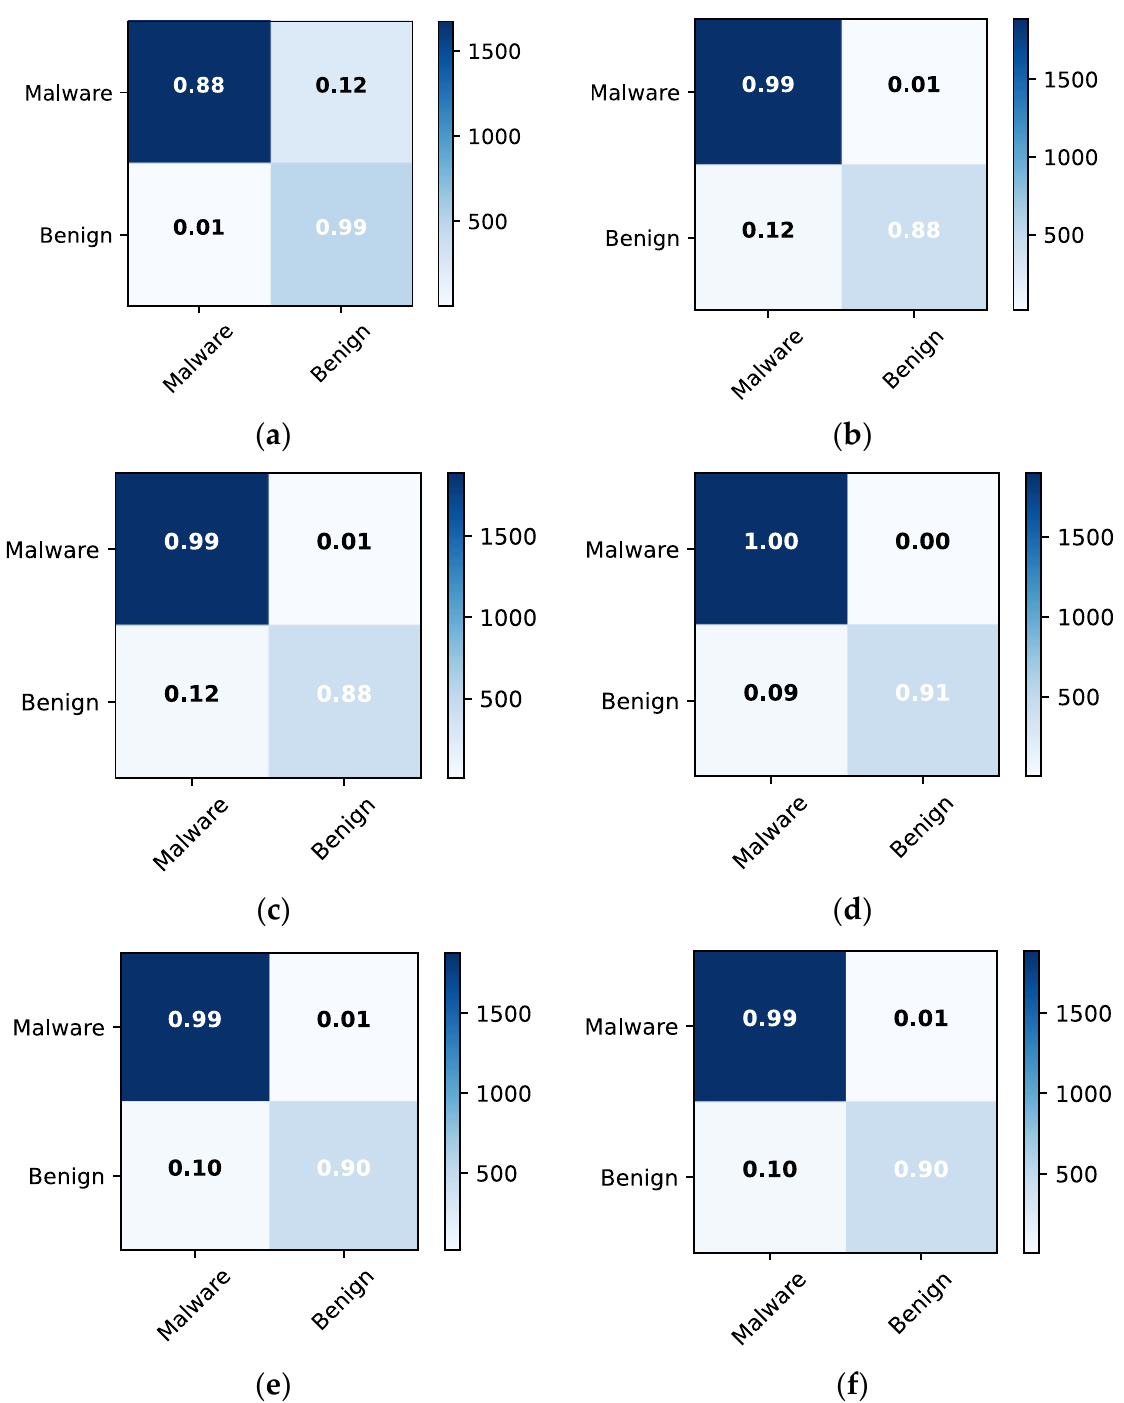
Figure 7. Confusion matrices for malware detection using dataset 2 with 256 × 256. ( a ) GNB; ( b ) SVM; ( c ) DT; ( d ) LR; ( e ) RF; ( f ) ensemble.